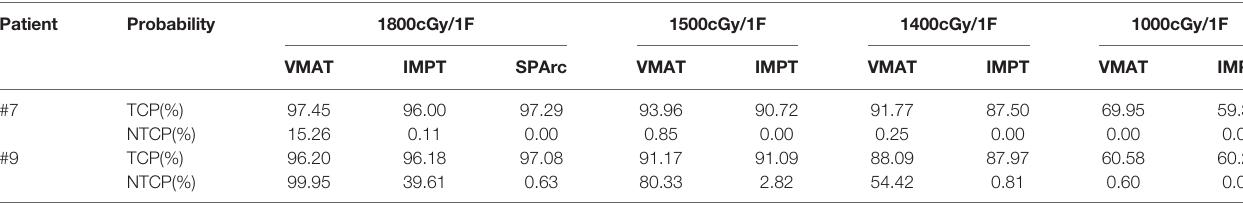
TABLE 5 | The TCP and NTCP for dose de-escalation in patient #7, and #9. Patient